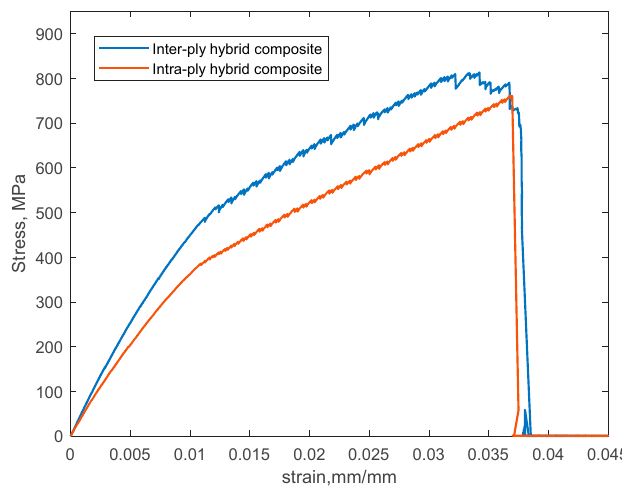
Figure 3. Tensile test curve for inter-ply and intra-ply flax-carbon hybrid composites.